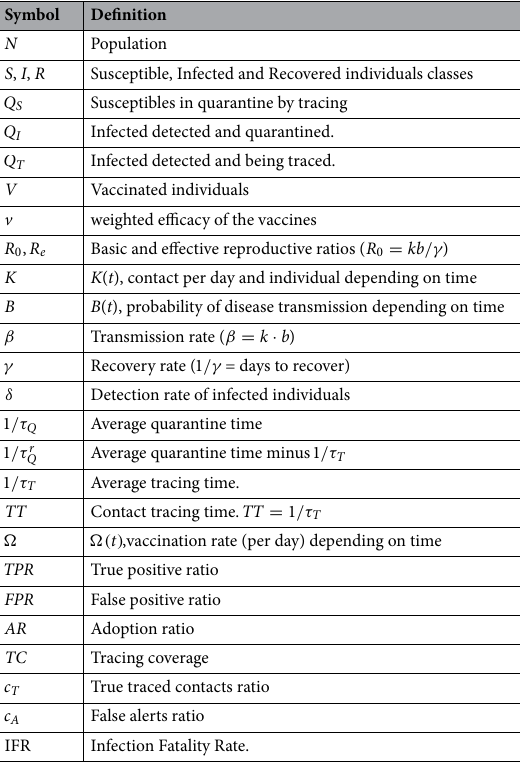
Table 1. Notation table.